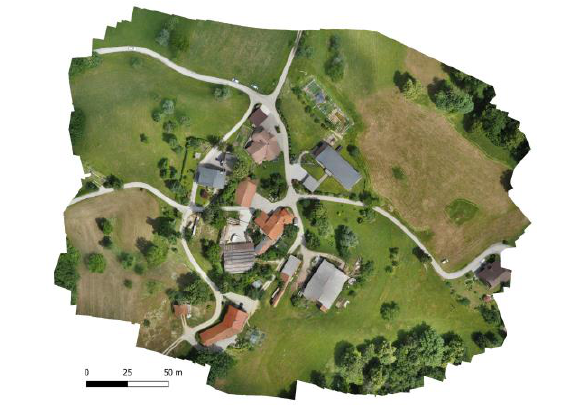
Figure 2. Orthomosaic of the study area.